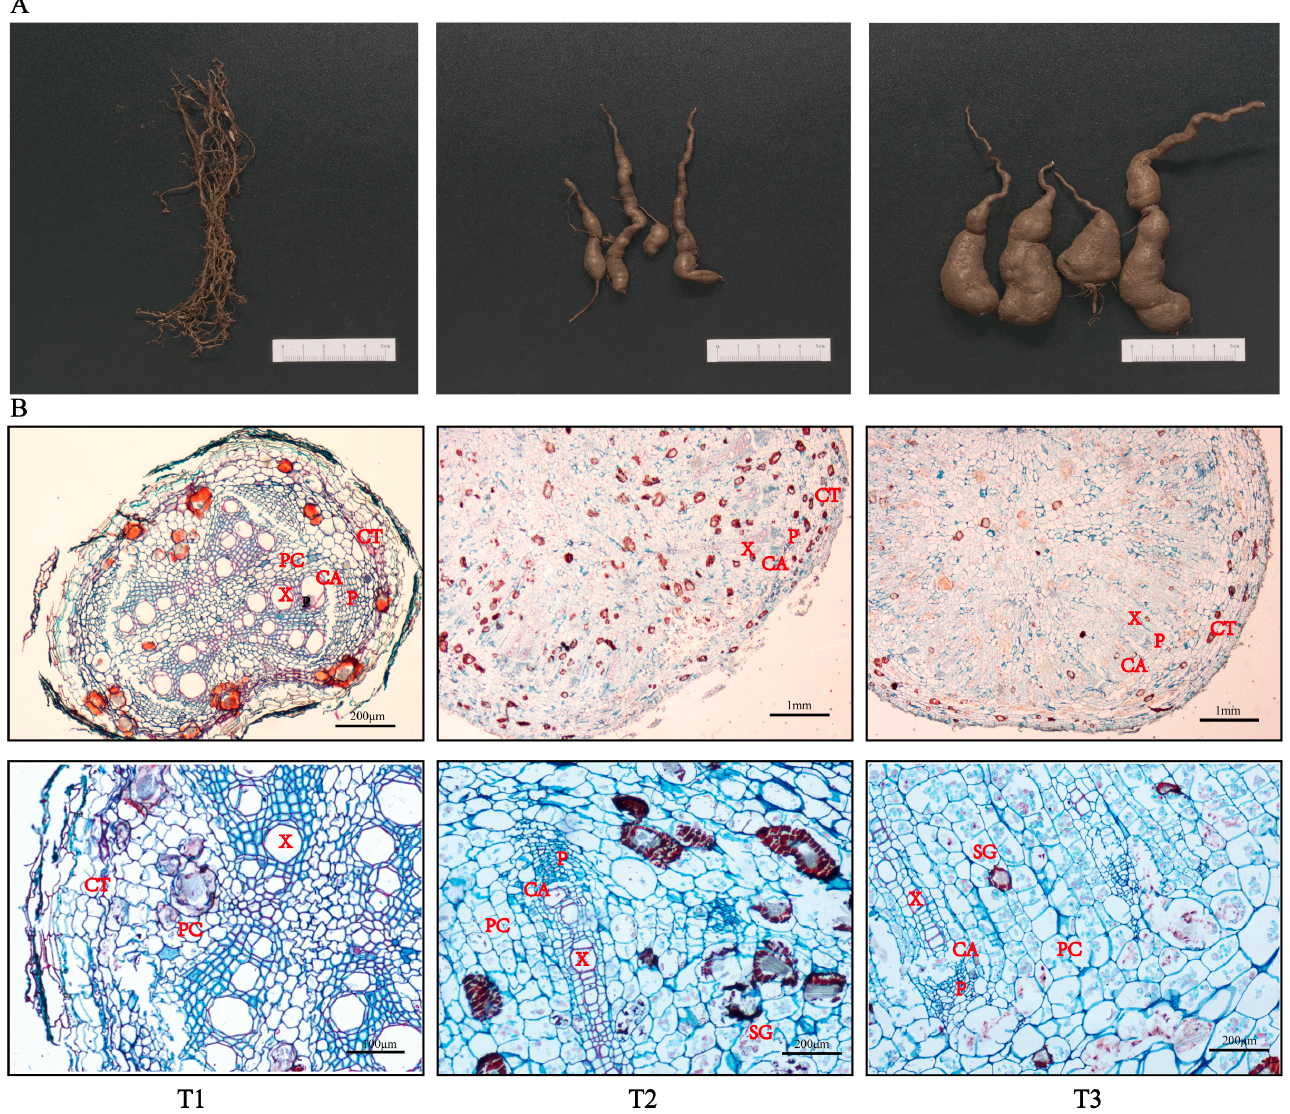
Figure 1. Physiological changes in different developmental stages of SYQ roots. ( A ) Morphology of roots. ( B ) Transverse sections of roots at different microscopic magnifications. Abbreviations: CA, cambium; CT, cortex; PC, parenchyma cell; X, xylem; P, phloem; SG, starch granules. The upward picture is the overall structure of SYQ roots at different developmental stages, and the picture below shows the details of the above image after